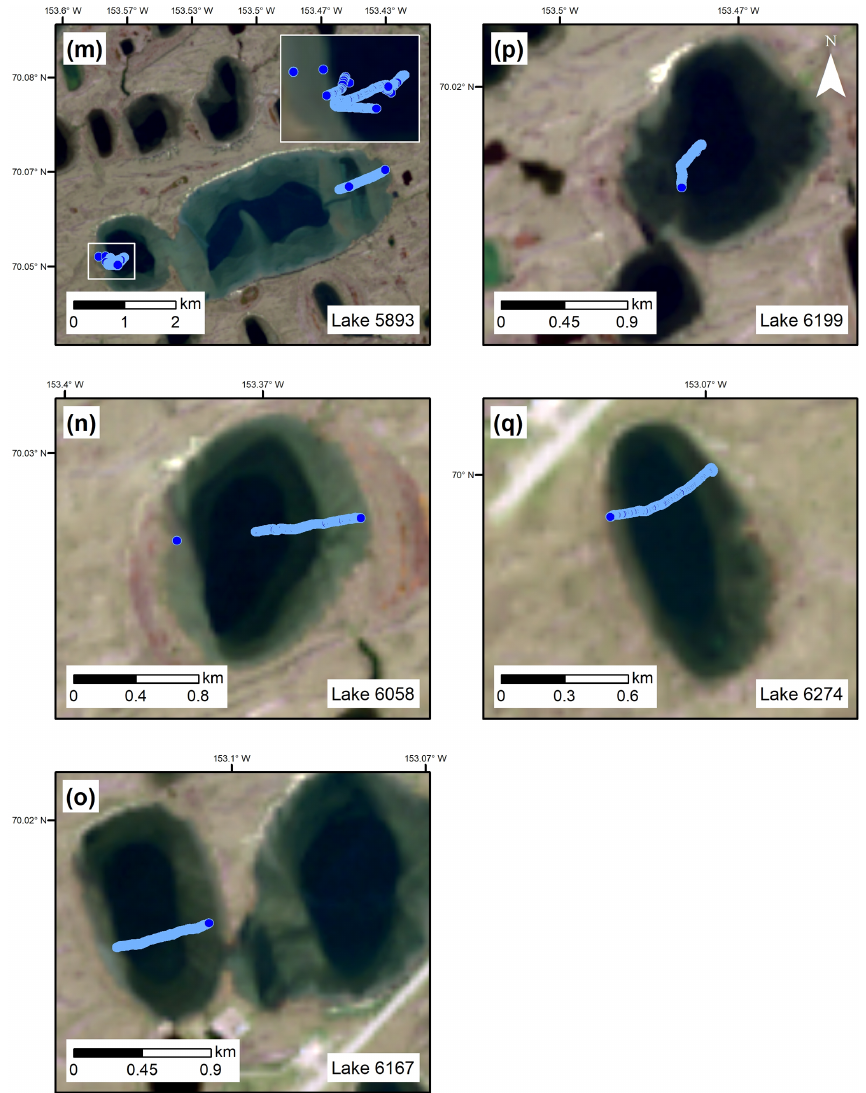
Figure 2. Transects were measured across 17 study lakes. Although the transects follow irregular paths (due in part to wind conditions and sonar error), all but two of the transects capture a range of depths from the deep central basins to the shallow outer shelves. These are the full transects before resampling to a single point per pixel. Where the form of a transect is unclear, inset maps are provided. Landsat-8 image is courtesy of the US Geological